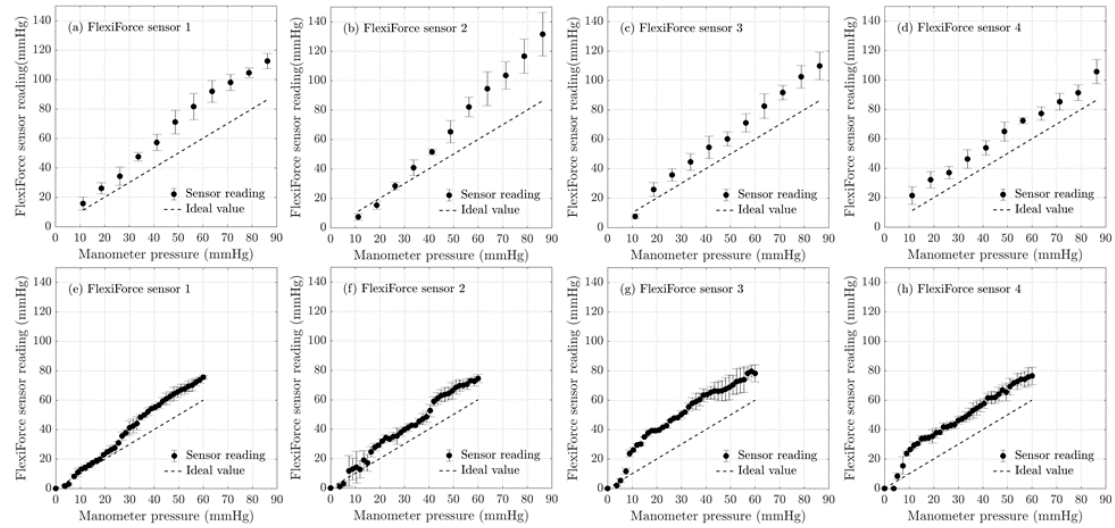
Figure 4. The results obtained using the bladder test: validation of FlexiForce ® sensors readings against the manometer reading (standard weight calibrated). The error bars represent the 95% confidence interval. ( a – d ) represent the FlexiForce ® sensors of batch one and the ( e – h ) represents the FlexiForce ® sensors of batch two.